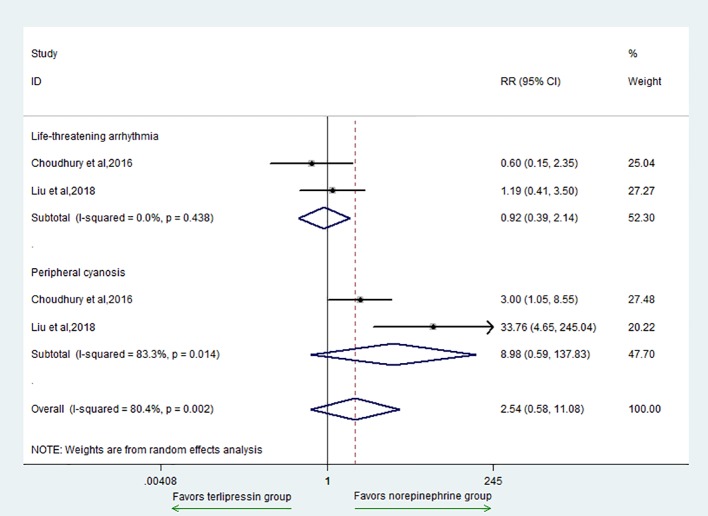
Forest plot of AE.